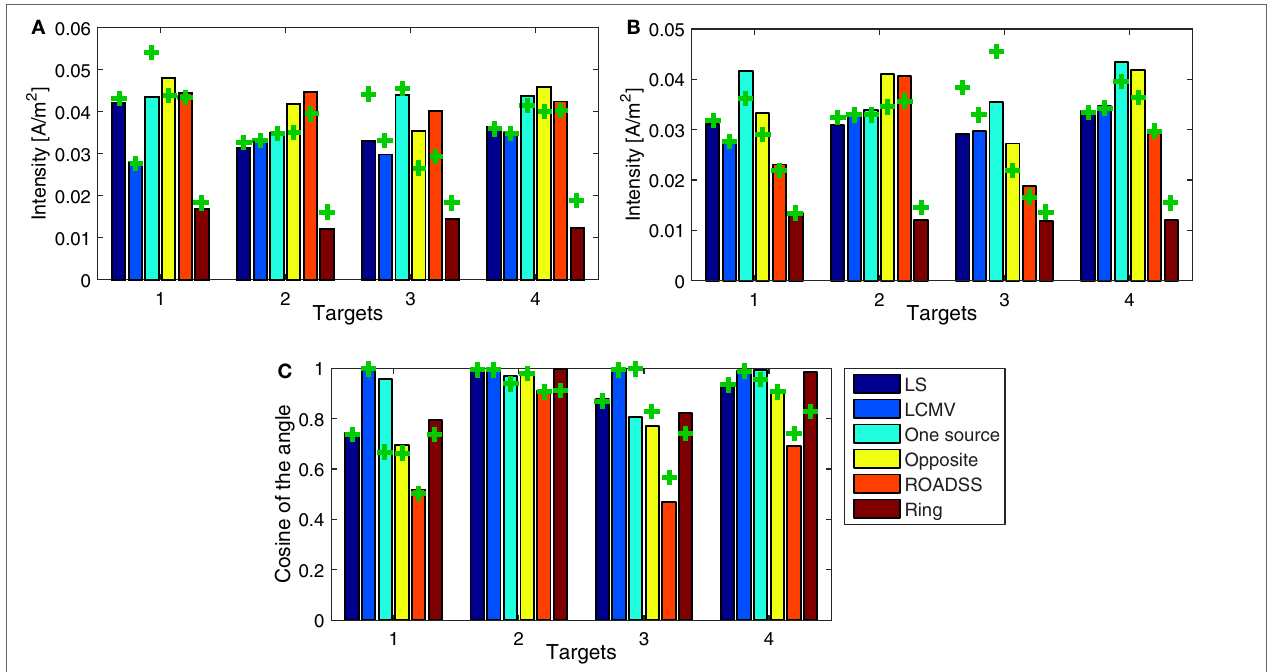
FIGURE 11 | Comparison of quantitative metrics of targeting between different methods. (A) Module of the total current density at each target; (B) directional current density on the target as the dot product between the current density and the unitary normal vector at each target surface; and (C) the normalized dot product between each target normal and the resulting current density. The bars depict the results for the 256 electrode net while the “ + ” marks correspond to the 128 sensor net. The total current injected in each case is 1mA.